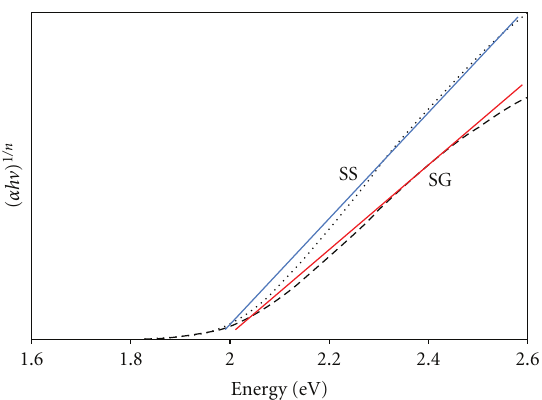
Figure 4: Bandgap determination of Sm 2 FeTaO 7 .